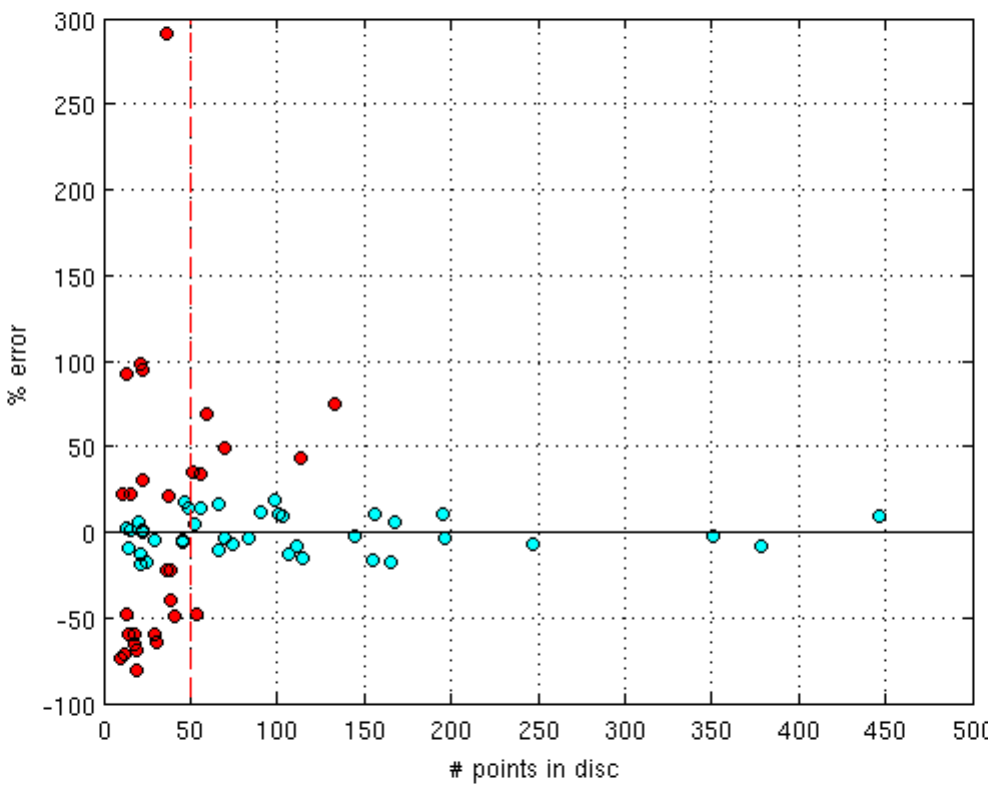
Figure 10. Relative error in diameter estimation vs . the number of points in the disc used for circle estimation. Red points indicate errors of at least 20% of the tree diameter, and cyan points mark errors less than 20%. For discs with less than 50 points (left of the red vertical line), the occurrence of gross errors is